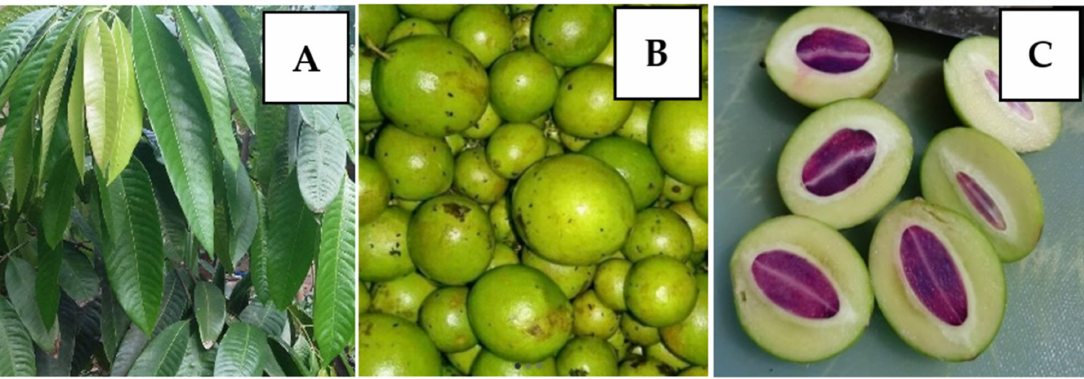
Figure 1. Bouea macrophylla Griffith; ( A ) leaves, ( B ) fruits, ( C )